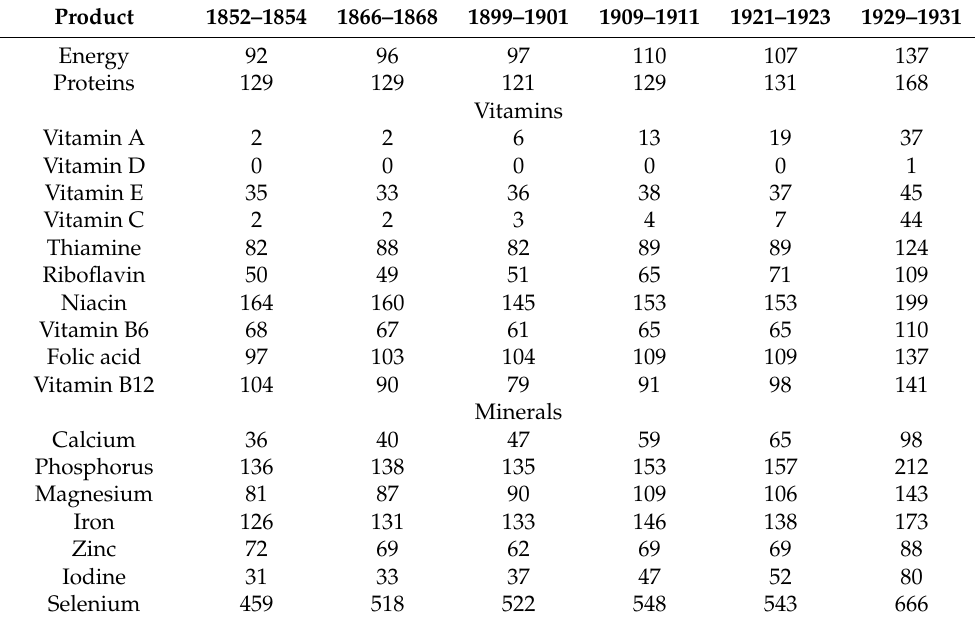
Table 4. Contribution of energy and nutrients with respect to the Recommended Dietary Allowances (RDA = 100) in the average daily diet of foundlings in the Hospital General de Valencia, 1852–1931.